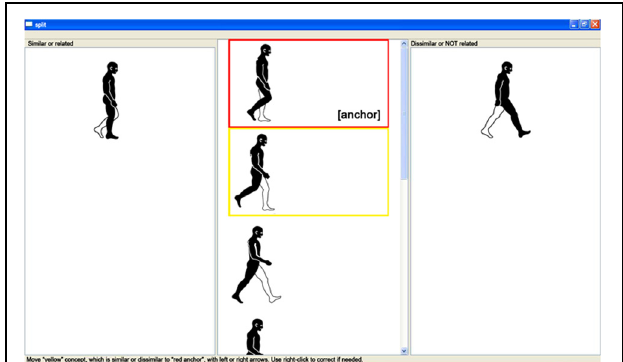
FIGURE 2 | Screenshot of the splitting procedure. One picture was presented in the anchoring position (top picture in the middle column as indicated by a red rectangle) to which participants classified the remaining N-1 pictures (presented in the lower half of the middle comlumn as indicated by a yellow rectangle) as similar (left column) or dissimilar (right column) to the anchoring